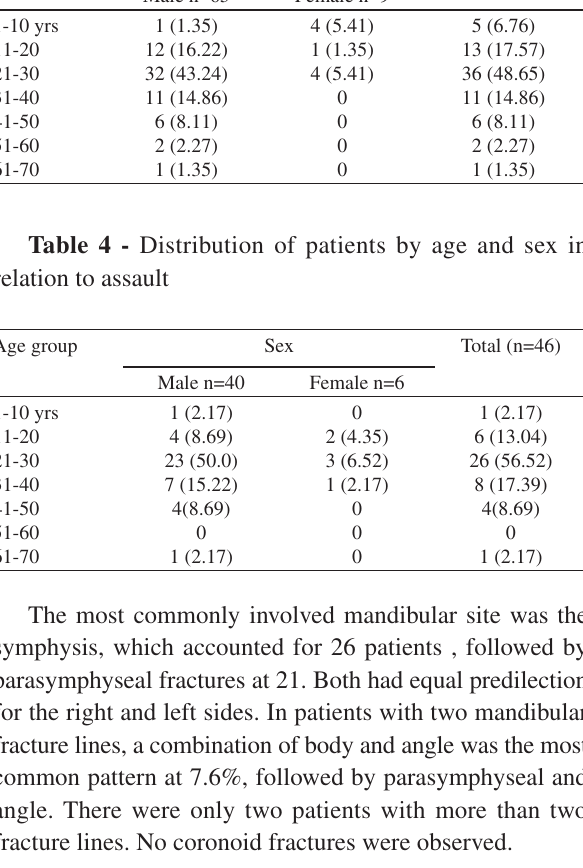
Table 5 - Distribution of maxillofacial fracture patterns according to cause of injury Causes Pattern of fractures Total (n=132) Mandible only Midface only Mid-face and